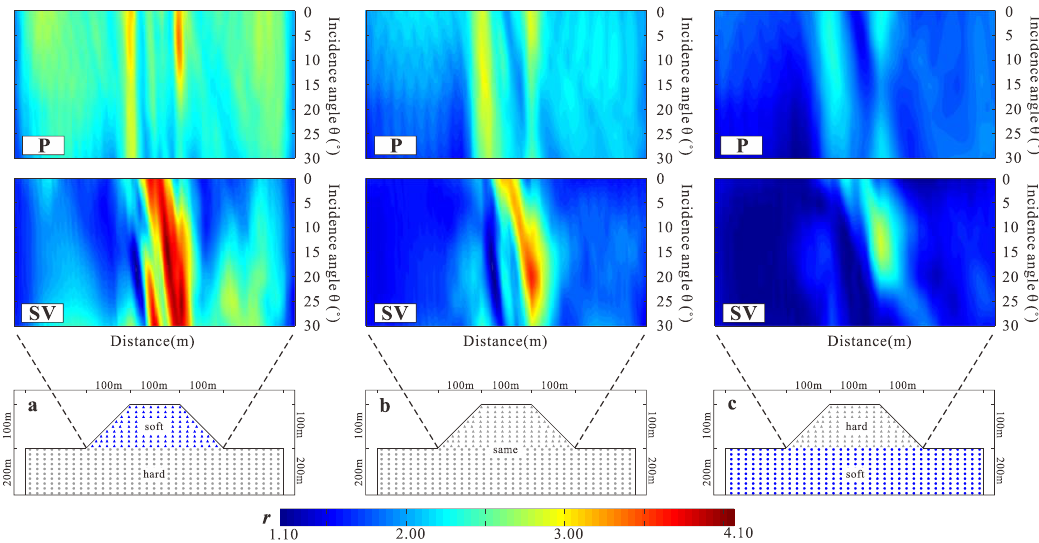
Figure 15. Variations of the seismic responses along the slope ridges and the slope crests of the real amplification ratio ( r ) of PGA with varied angles of wave incidence under different materials. ( a ) slope soft while foundation hard, ( b ) slope and foundation are same, ( c ) slope hard while foundation soft.